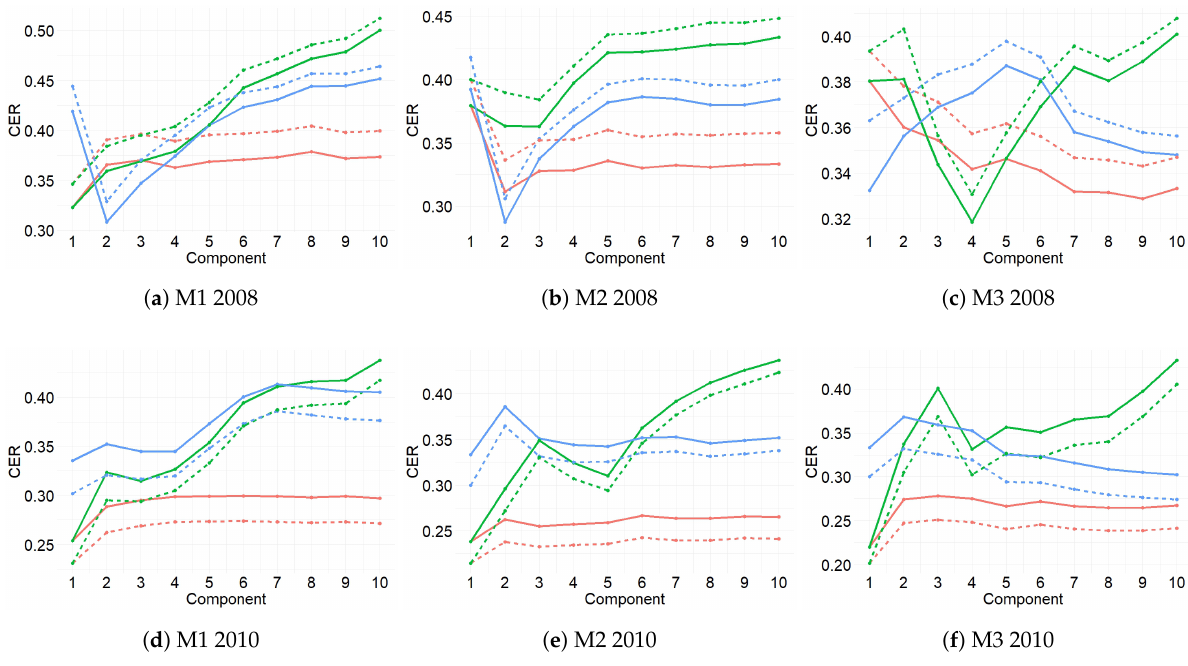
Figure 7. Classification error rate (CER) from PLS-DA for 10 components. The CER was computed for each prediction distance (maximum, centroid, and Mahalanobis) per method (M1, M2, and M3) for 2008 and 2010. Two types of error rate are indicated: balanced BER (dashed lines) or Overall (solid lines). Blue lines refer to maximum distance, red lines to centroid distance, and green lines to Mahalanobis distance. PLS-DA was carried out using repeated three-fold CV 1000 times. For 2010, BER and centroid distance showed the best performance achieved by one component. In 2008, M1 and M2 performed the best for maximum distance and Overall, while Mahalanobis distance performed the best in M3. The second-best distance for the three methods was the centroid